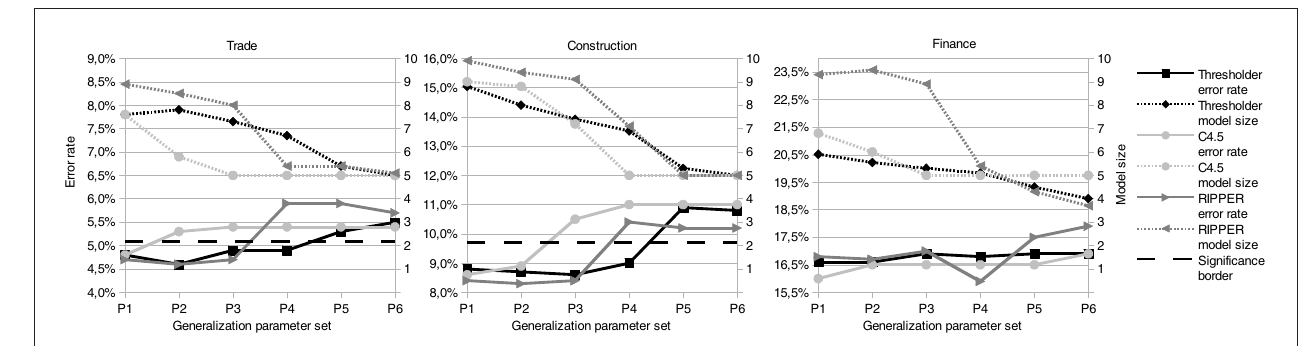
FIGURE 2 | Error rate and model size for different generalization parameters. A border is plotted between the results which are not significantly worse and the results which are significantly worse than the best result. No border is plotted for the finance data set because there are no results which are significantly worse than the best